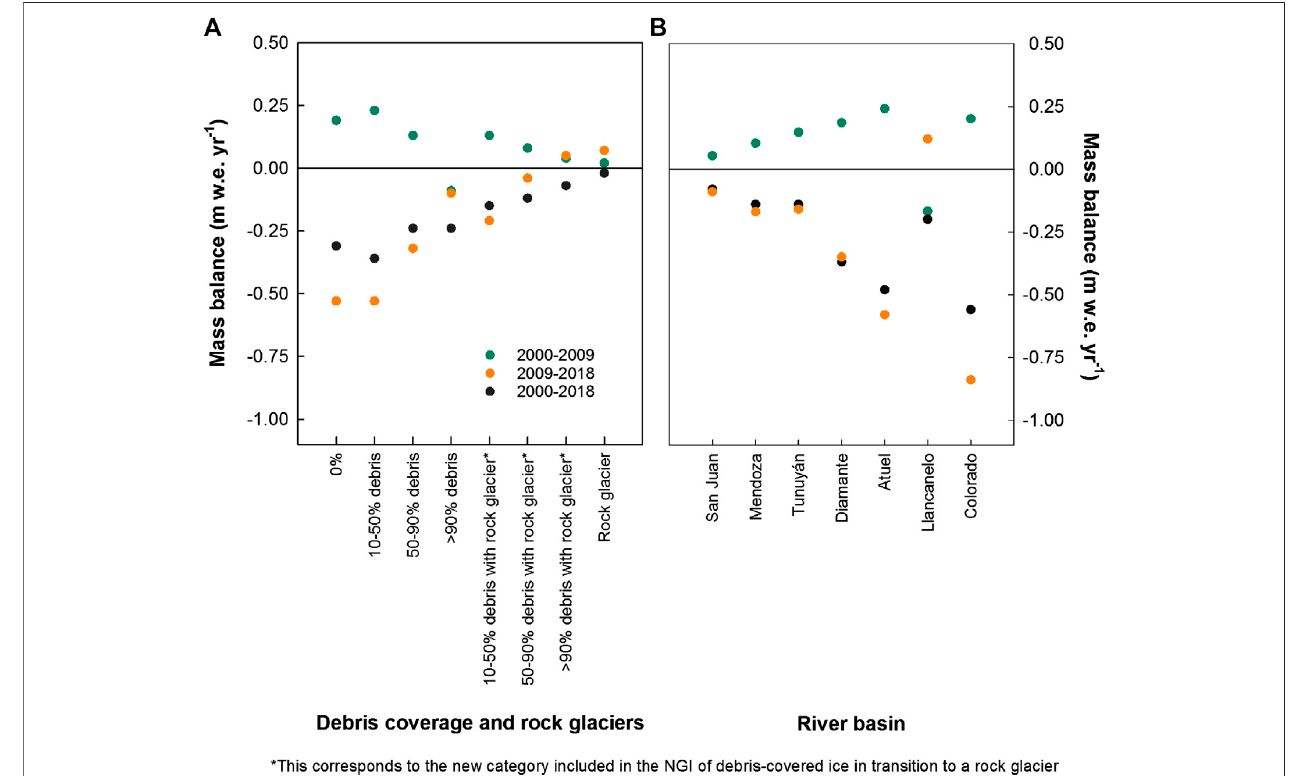
FIGURE 5 | (A) Mass balance rates for different ice masses based on the percentage of debris coverage for the period 2000 – 2018 and for the sub-periods 2000 – 2009 and 2009 – 2018. (B) Mass balance rates averaged for the main river basins in the study area.